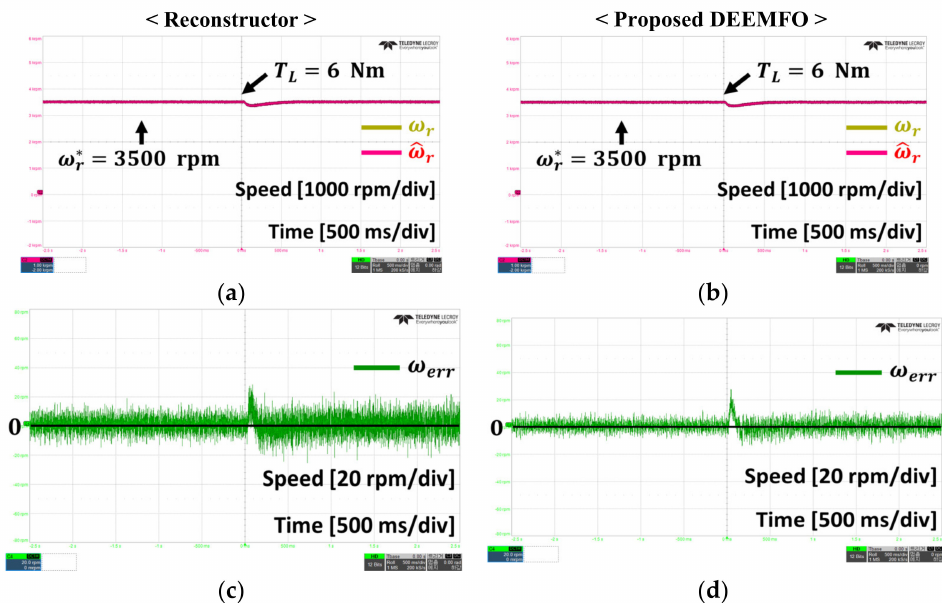
Figure 16. Summary of the experiment results under the condition of increasing the load torque from 0 Nm to 6 Nm. ( a ) reference, real, and estimated speed with reconstructor; ( b ) reference, real, and estimated speed with DEEMFO; ( c ) speed error in reconstructor; ( d ) speed error in DEEMFO.